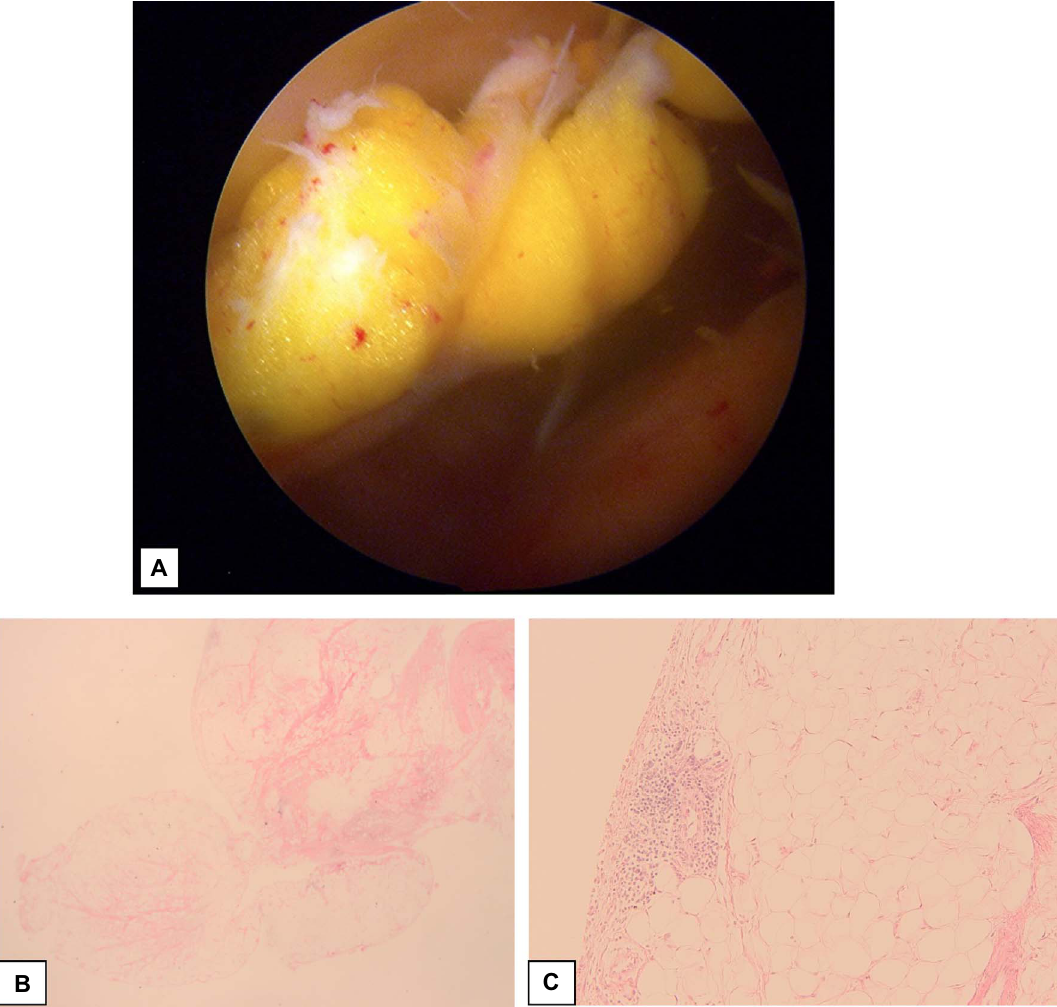
Figure 2. (A) Intra-operative subdeltoid lipomatous mass pre-excision. (2.3 (cid:1) 1.0 (cid:1) 0.5 cm). (B and C) Histologic features of lipoma Arborescence: (B). Papillary lipomatous proliferation (C). Lipomatous lesion with surface synovial lining and a focus of lymphoplasmacytic in fi ltration (H&E